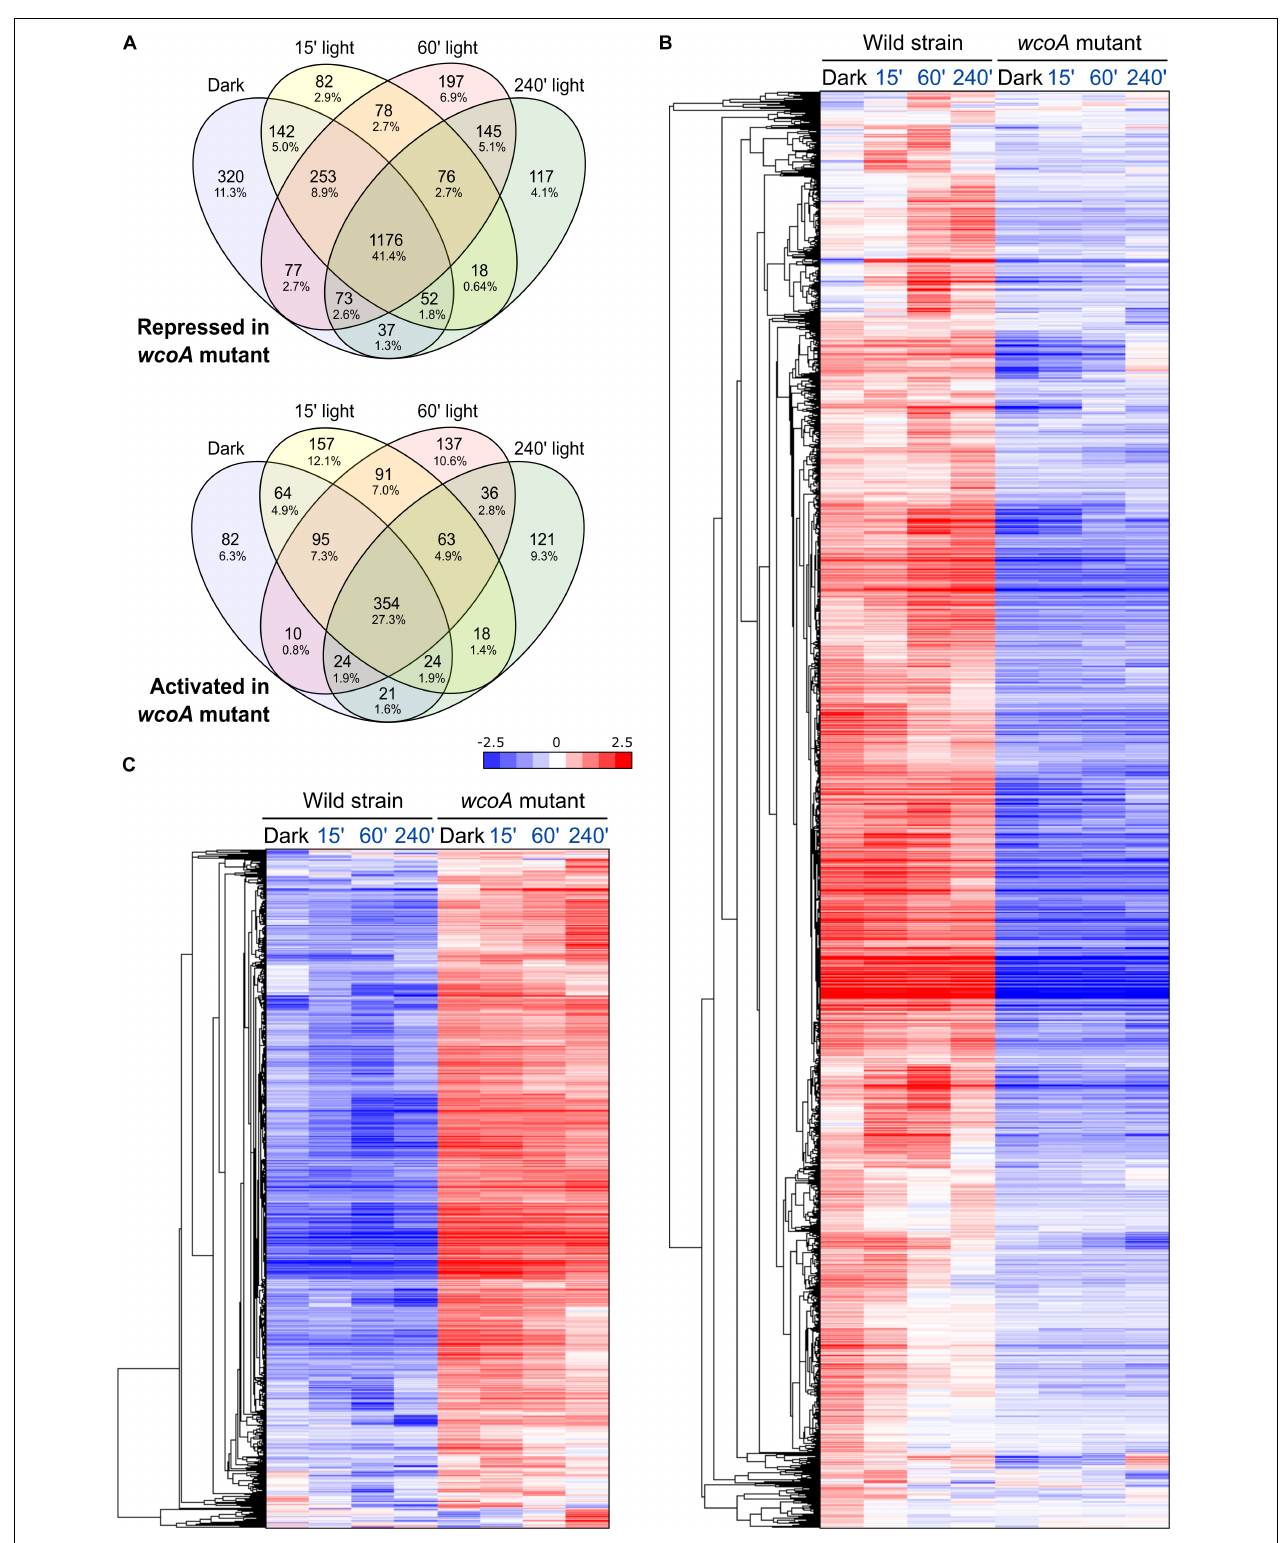
FIGURE 4 | Effect of the wcoA mutation on the F. fujikuroi transcriptome under different light regimes. (A) Venn diagrams of the genes repressed (above) or activated (below) in the wcoA mutant in the dark or after the illumination times indicated. (B,C) Hierarchical heatmaps of the genes repressed (B) or induced (C) in the wcoA mutant under the illumination times indicated